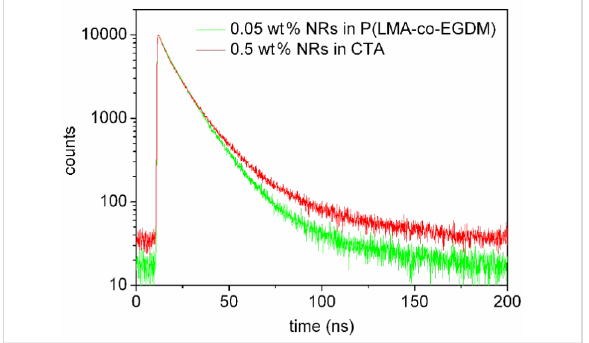
Figure 11: Decay curves of P(LMA- co -EGDM) and CTA nanocompos- ites containig aspect ratio 6 NRs.